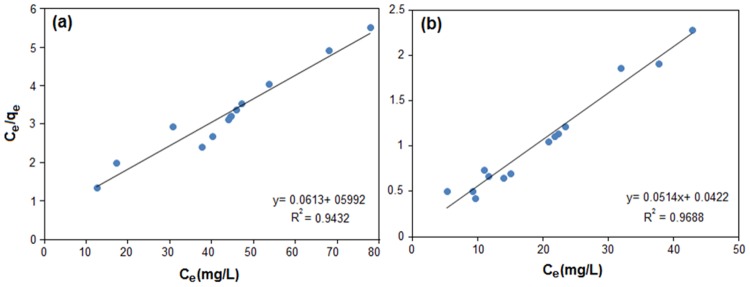
Langmuir isotherm plots of the biosorption of Cu(II) (a), and Pb(II) (b) by RS/Fe3O4-NCs.